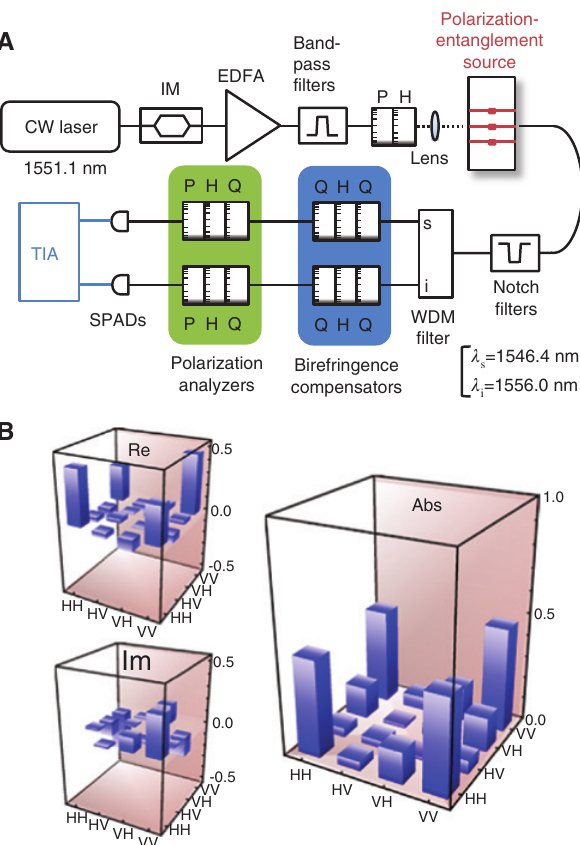
Figure 4: (A) Experimental setup for the measurement of polariza- tion entanglement from the chip. IM: intensity modulator, EDFA: Erbium-doped fiber amplifier, P: polarizer, H: half-wave plate, Q: quarter-wave plate, WDM filter: wavelength-division multiplexing filter. Dashed and solid lines show free-space optical path and electrical connection. (B) The reconstructed density matrix of the two-photon polarization state generated from the chip. H and V represent the TE and TM modes, respectively